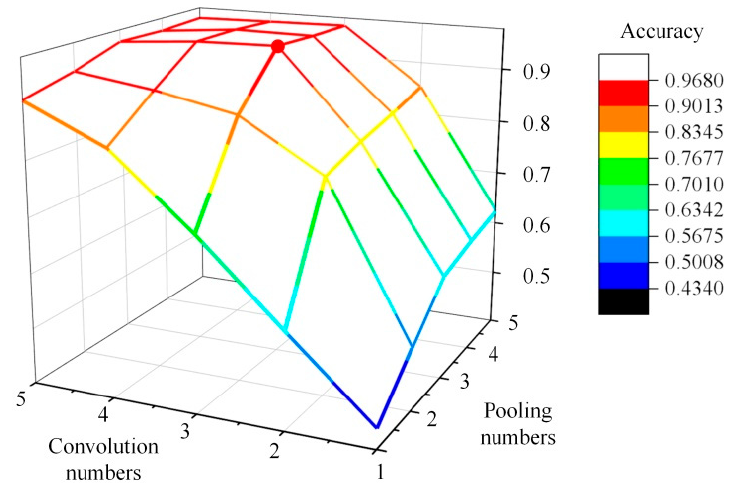
Figure 9. Classification accuracy of the model under different numbers of convolutional and pooling layers.